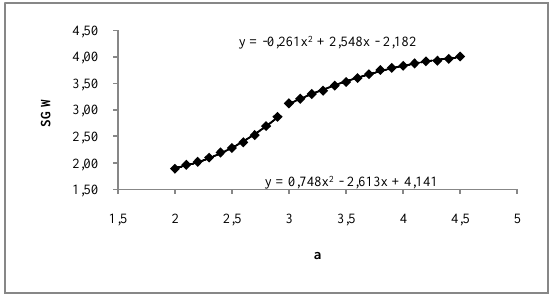
Fig. 26. Chart of S GW parameter and cosine function parameter.